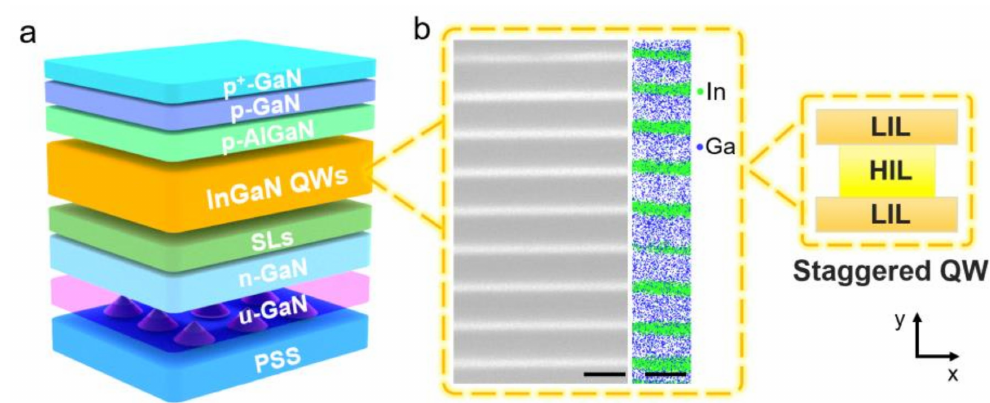
Figure 1. ( a ) Schematic of epitaxial structure of LED based on staggered InGaN QWs. ( b ) Cross- sectional TEM image and APT-reconstructed atom map of QWs in LED epitaxial structure. Scale bar: 20 nm; x axis: energy; y axis: growth